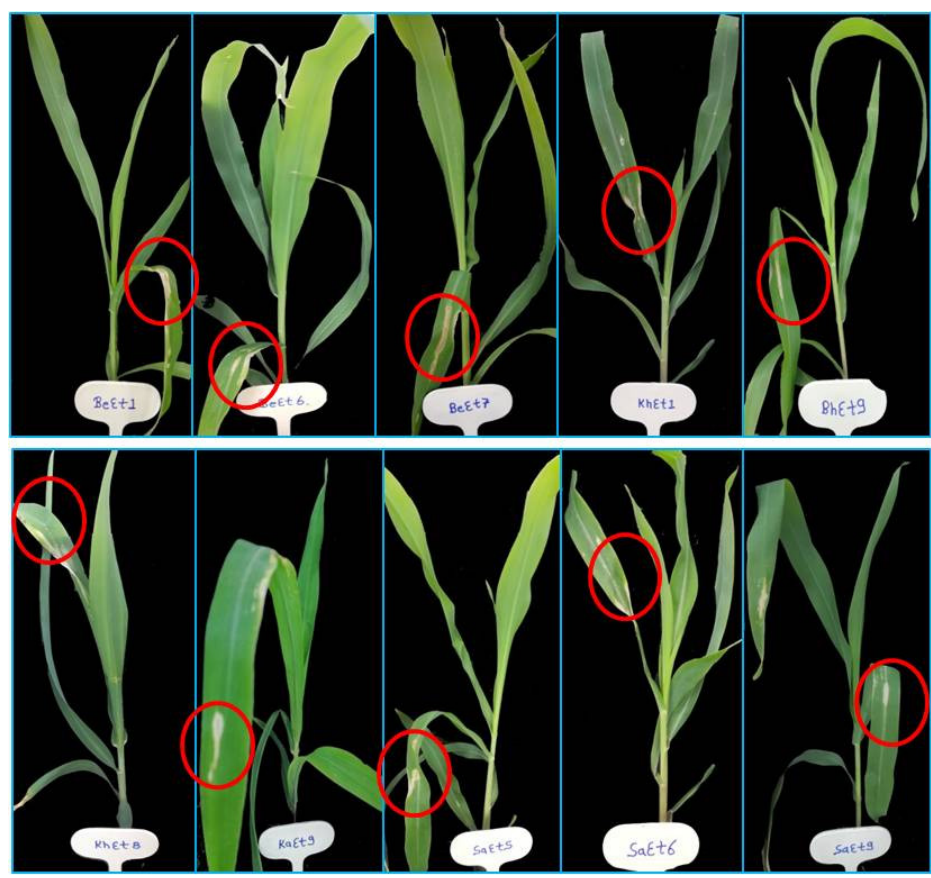
Bioengineering 2022 , 9 , x FOR PEER REVIEW Figure 3. Disease reaction of E. turcicum race 1 on differential line ‘33′ after 14th days of inoculation. Figure 3. Disease reaction of E. turcicum race 1 on differential line ‘33 (cid:48) after 14th days of inoculation.